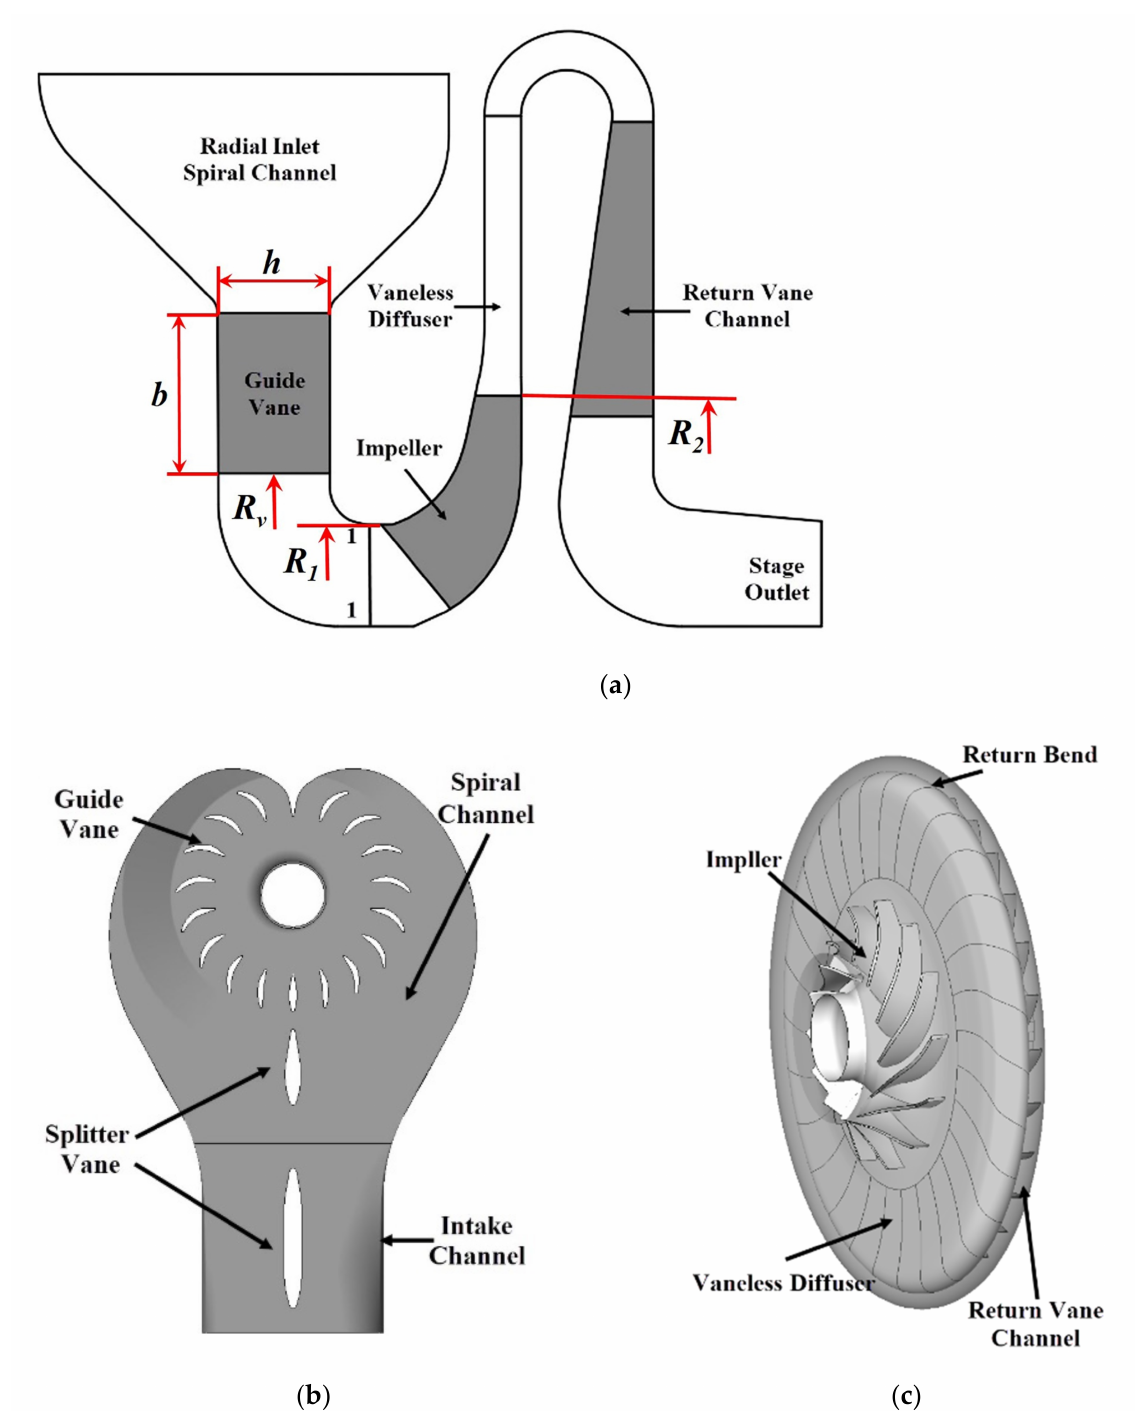
Figure 1. Description of ( a ) the compressor meridian profile, ( b ) the radial inlet with guide vane, and ( c ) first stage of the